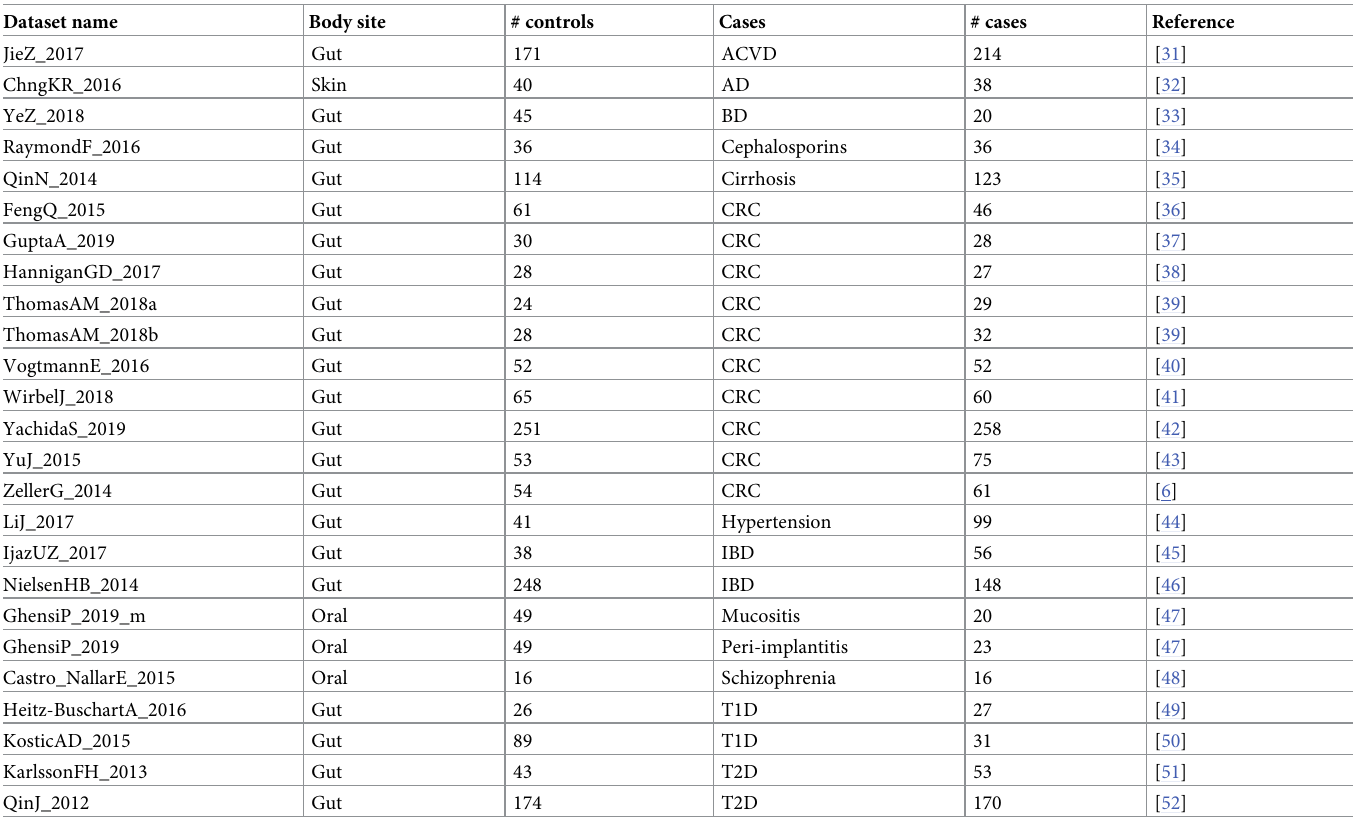
Table 1. Summary of the 25 classification tasks derived from metagenomic datasets for case-control prediction. ACDV: Atherosclerotic cardiovascular disease, AD: Alzheimer’s disease, BD: Behcet’s disease, CRC: Colorectal cancer, IBD: irritable bowel disease, T1D: Type 1 diabetes, T2D: Type 2 diabetes. We additionally considered the HMP_2012 dataset [10] for body site discrimination between gut (N = 414) and oral (N = 147)